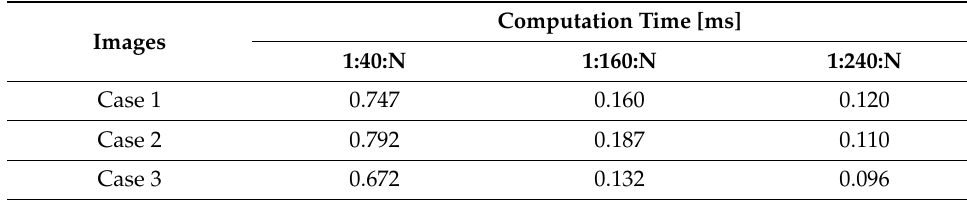
Table 4. Computation time of the PV modules using PCA.